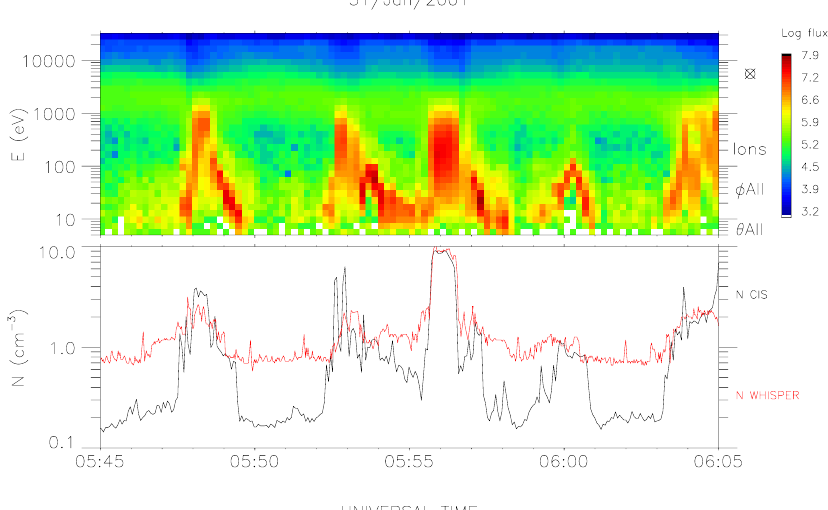
Fig. 9. Densities comparisons. Top panel, the CIS-2 energy-time spectro- gram. Bottom panel, the plasma densi- ties computed from the CIS instrument (black curve) and from the plasma fre- quency measured by the WHISPER ex- periment (red curve). Note that both curves agree only in structures where the plasma is flowing (see Fig. 3). In- side non-flowing plasma regions, the densities differ by a factor of ∼ 4 which is attributed to the effect of the satellite potential (see